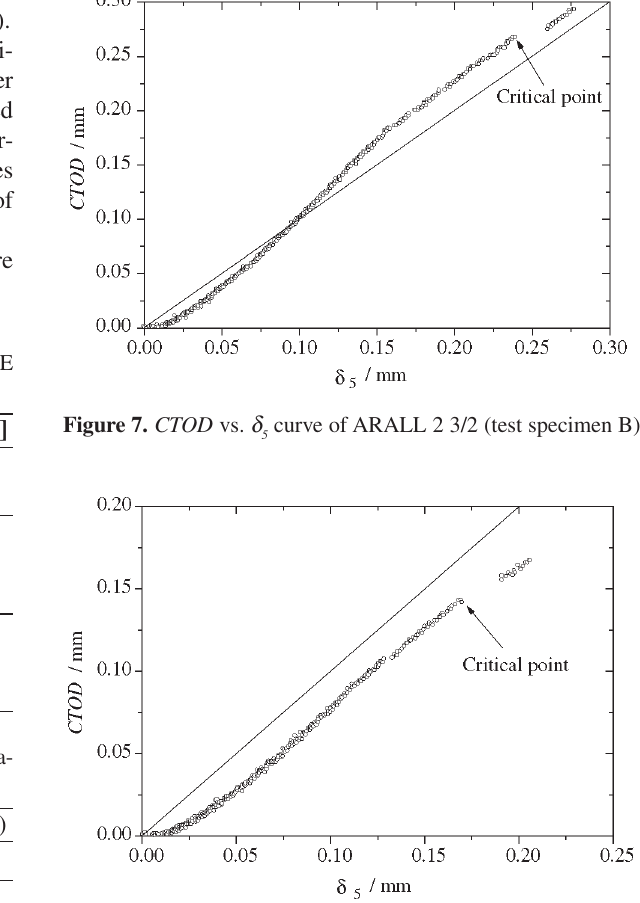
Figure 8. CTOD vs. δ